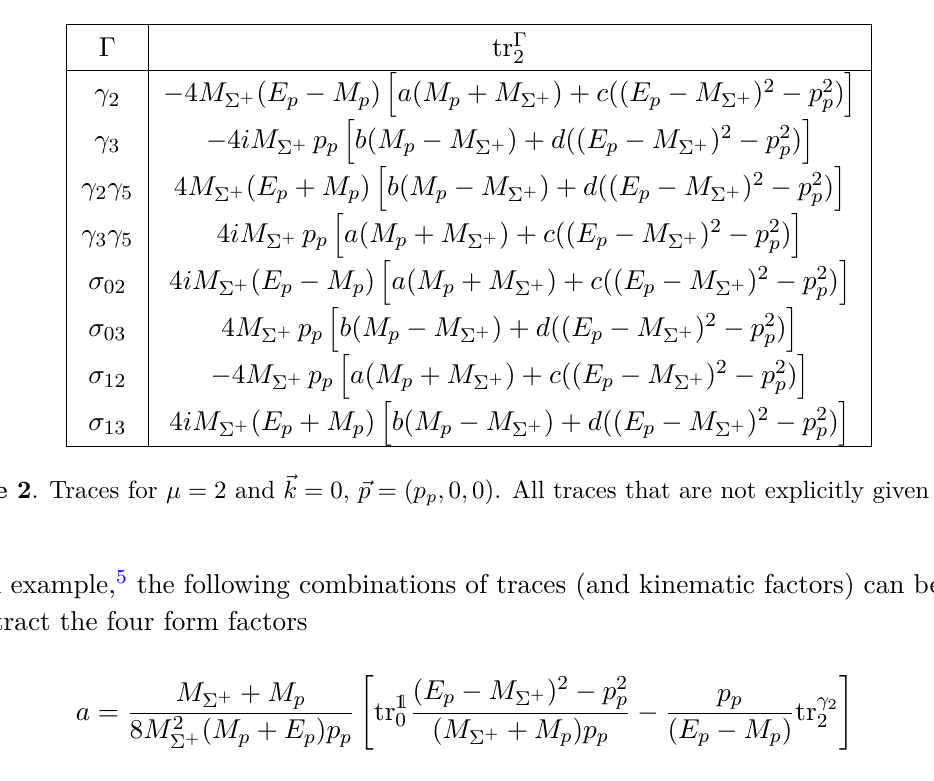
Table 1 . Traces for µ = 0 and ~k = 0 , ~p = ( p p , 0 , 0) . All traces that are not explicitly given are 0 .